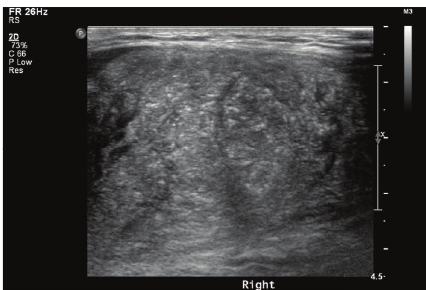
Figure 1: Thyroid ultrasonography of a 13-year-old girl with Hashimoto’s thyroiditis. Enlarged, lobulated, diffusely contoured thyroid lobes with many scattered microcalcifications are evident.